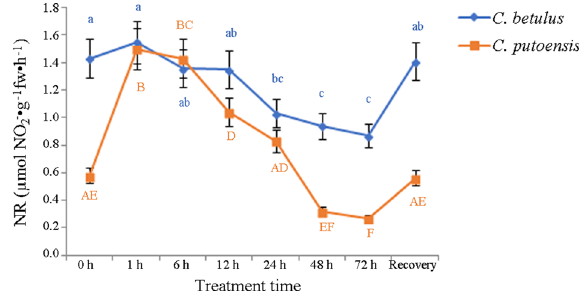
Figure 5. Changes in the NR activity of C. betulus and C. putoensis under NO 2 stress at different time points and after self recovery. Letters or letter combinations containing the same letter indicate no significant difference between the corresponding NO 2 exposure time points in the same plant species according to ANOVA or nonparametric Kruskal–Wallis ANOVA followed by Bonferroni tests. Capital letters for C. putoensis and lower letters for C. betulus.